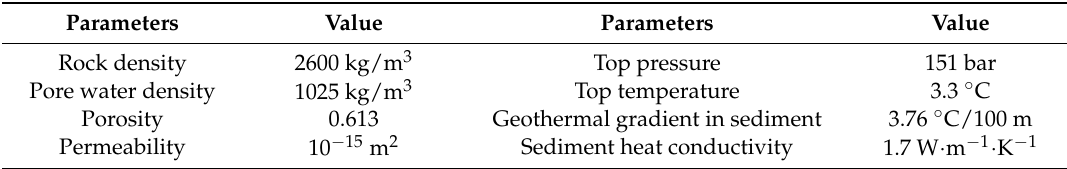
Table 2. Physical parameters of the